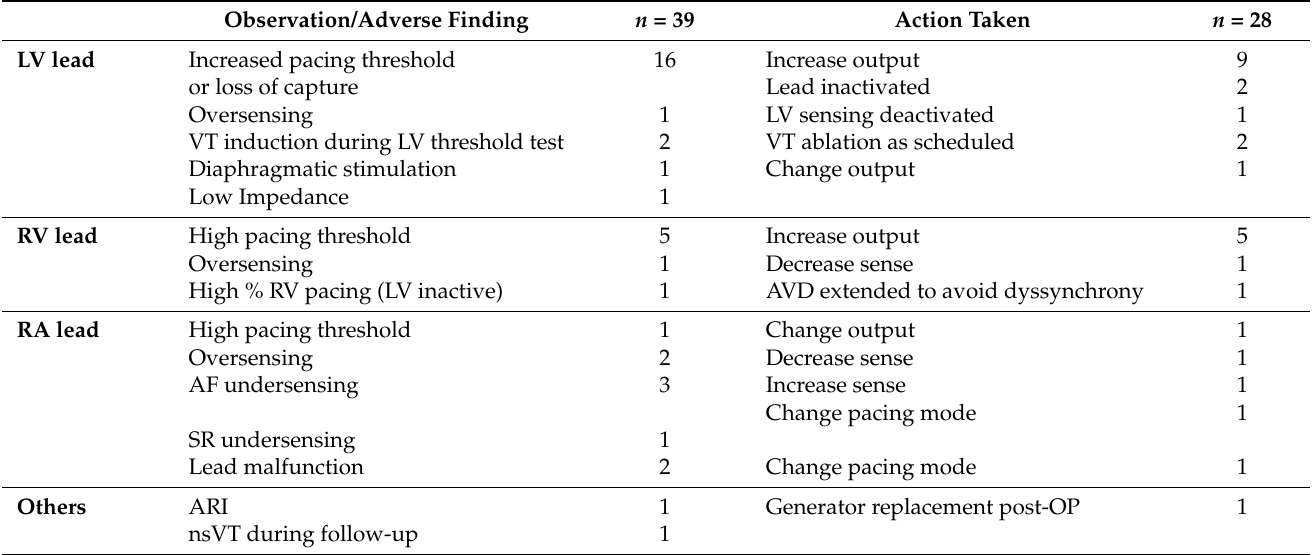
Table 4. Preoperative CRT interrogation. Observations and adverse findings in 180 patients requiring intervention in 22 subjects.